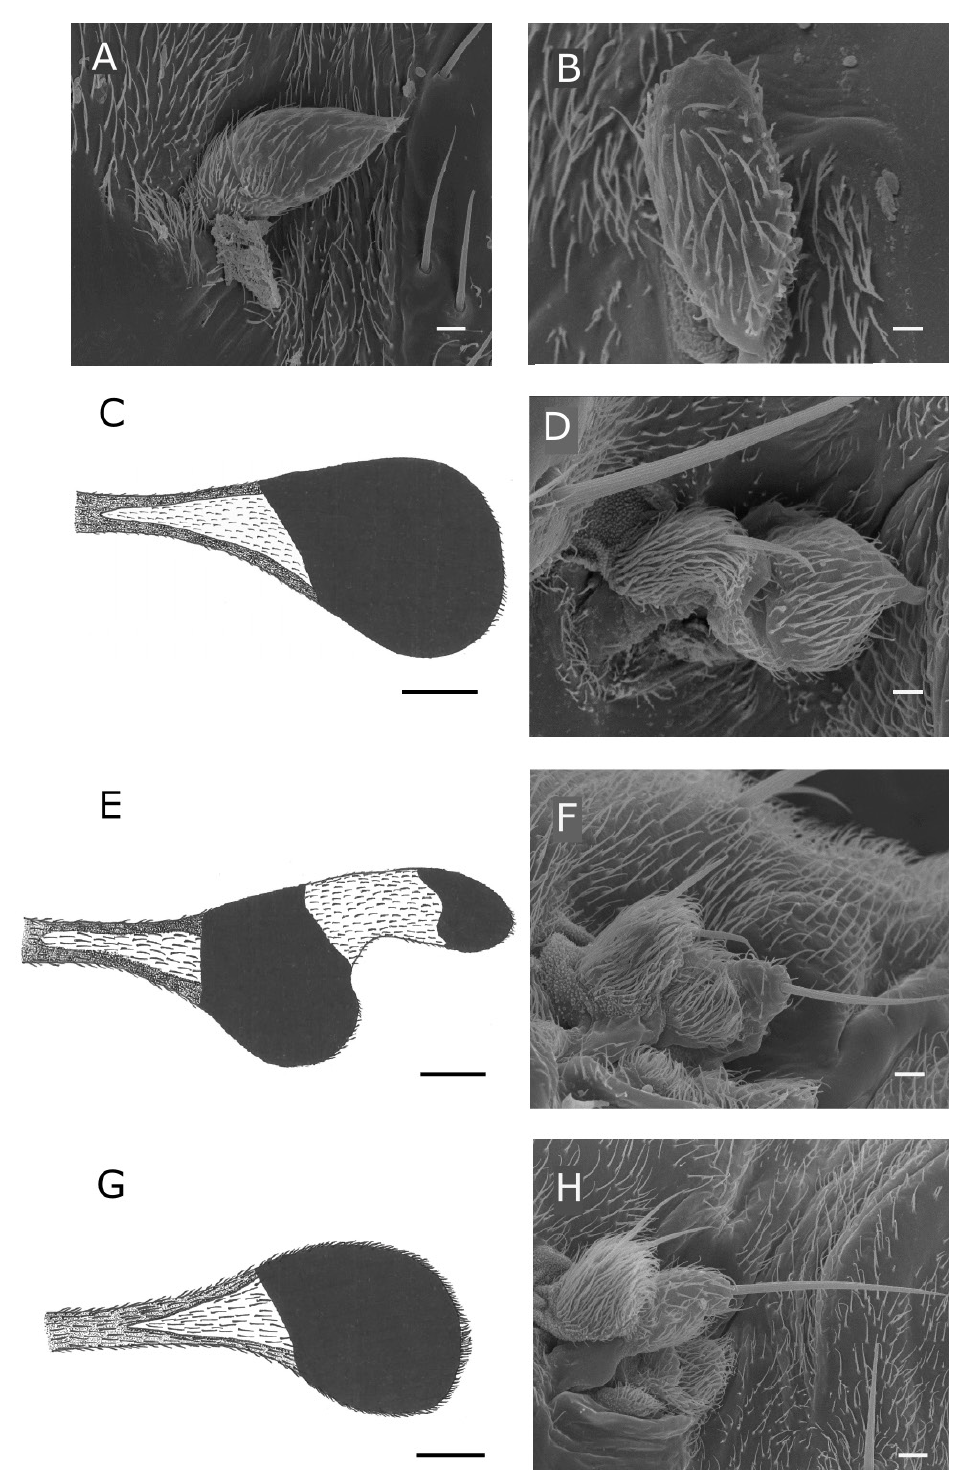
Fig. 20. Drawings of the tip of stenopterous wings and images obtained by scanning electron microscope (SEM) of the micropterous wings. Males are pictured in the left column, females in the